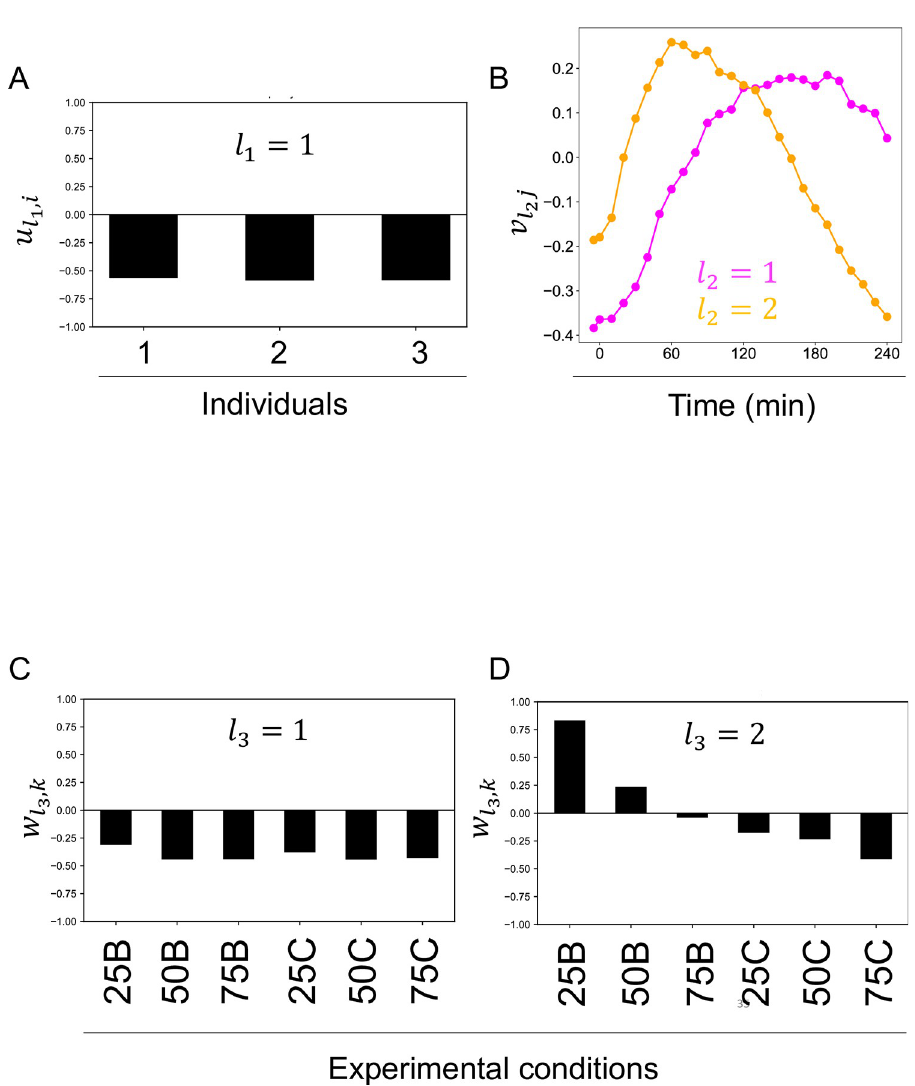
Fig 6. Singular vectors obtained by tensor decomposition ( ‘fourth-order tensor with individual mode , time mode , ; l ¼ 1 ). B Time- experimental condition mode , and molecule mode’ ). A Individual-related singular vectors ( u 1 l 1 i related singular vectors (Magenta line: v ; l ¼ 1 Orange liene : v ; l ¼ 2 ). C Experimental condition-related 2 2 l 2 j l 2 j singular vectors ( w ; l ¼ 1 ). D Experimental condition-related singular vectors ( w ; l ¼ 2 ). Each experimental 3 3 l 3 k l 3 k condition is denoted by the initial letters of the amount and duration of ingestion: 25B for 25 g bolus ingestion, 75˚C for 75 g-2 h continuous